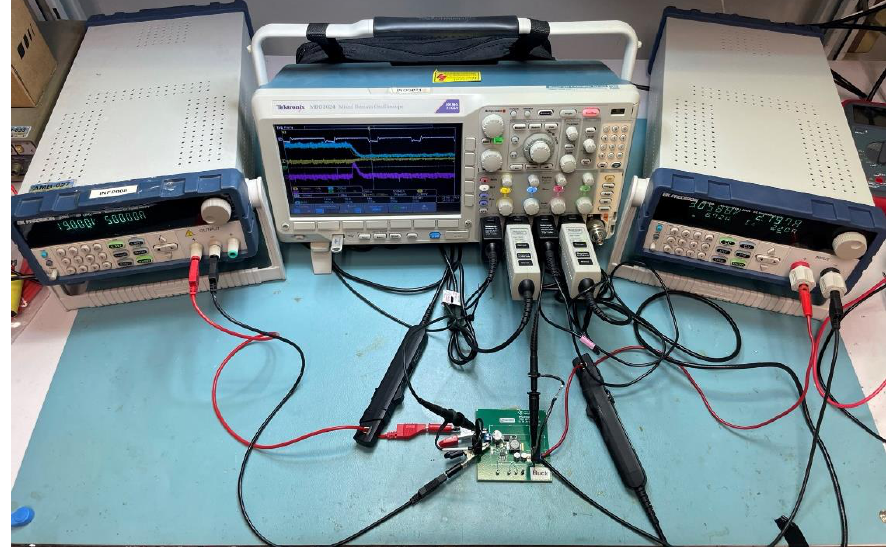
Figure 10. Experimental setup to acquire data from DC-DC converter.